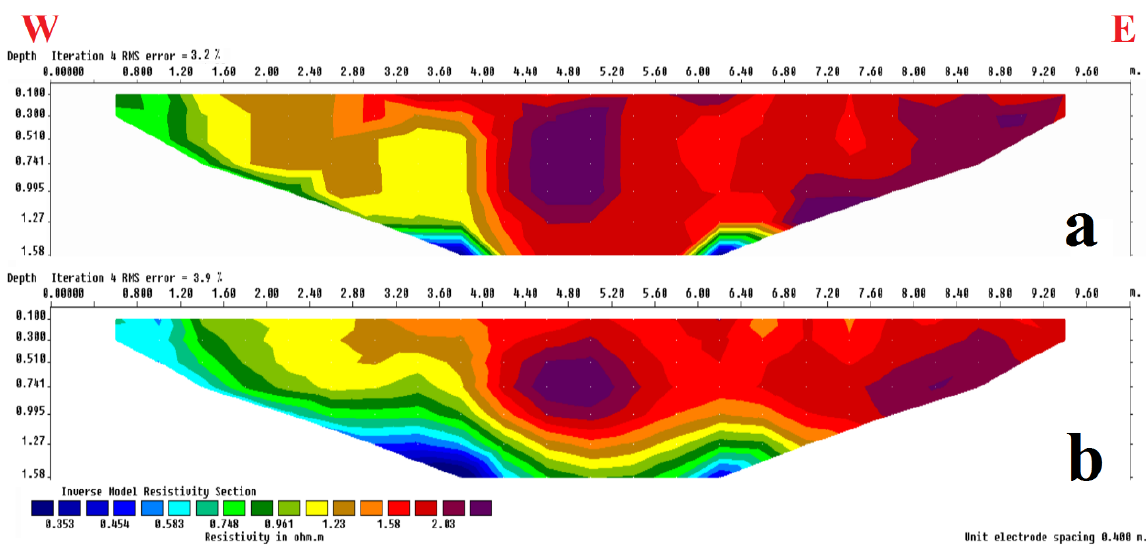
Figure 6. ERT models of the same section inverted using: ( a ) the robust inversion method, and ( b ) the least-squares smooth constrained method. Data were surveyed at Farm A in October 2021.